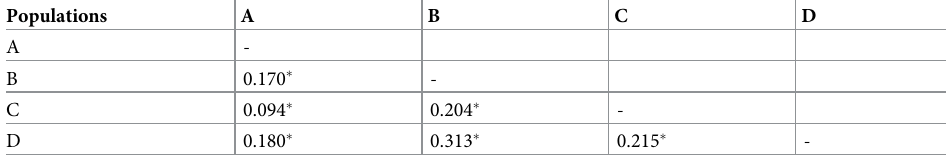
the pairwise F is between 0 and 0.05, it implies a low level of genetic differentiation between ST the populations [48]. In this study, the population genetic structure of the pairwise F values ST showed a significant genetic differentiation between the most populations, based on the analy- sis of the 16S rRNA and COI genes. Moreover, the phylogenetic analysis and haplotype net- work construction showed the lack of clear population genetic structures. This suggests that the gene flow within the C . siamensis population in Thailand might bring about genetic homo- geneity [49]. In this study, almost all of the pairwise F values, based on the 16S rRNA and ST COI sequences between the populations, were over 0.15. In contrast, the pairwise F based ST values on the 16S rRNA sequences, showed different results in some populations compared to the COI sequences. This suggested that the 16S rRNA gene had a relatively slow of evolution rate, and a low variability, compared to the COI gene [44, 50]. This agreed with the study of Feng et al. (2011), who found more variable nucleotide sites in the COI gene than in the 16S rRNA in the mollusk of the family Pectinidae. Genetic differentiation of C . siamensis popula- tion may be affected by the ecological environment, climate barriers, and geographic barrier factors [2, 29]. This was supported by previous studies that showed that the ecological environ- ment factor on population differentiation, has been reported in other land snails, such as Camaena cicatricose [29] and Cyclophorus fulguratus [42, 51]. In addition, the migration and expansion repeated of population from different areas lead to continuously mix the popula- tions of land snails. It is likely to affect accumulation of high genetic diversity within the popu- lation of the species. This was reported in pulmonate snail, Euhadra quaesita [52]. It may be possible reason leading to the genetic different in population of C . siamensis . The genetic homogeneity of C . siamensis in Thailand based on 16S rRNA and COI genes was found among some populations. The results suggested that extensive gene-flow was a pos- sibility. In support of this, considerable levels of gene-flow have been reported among C . sia- mensis populations in Thailand. Populations of C . siamensis in the areas with a low level of genetic differentiation, exhibit higher levels of gene flow than the populations with a high genetic differentiation [53]. Although this particular land snail has a low dispersal ability, the water, wind, anthropochory, and other factors, can lead to a wider distribution, especially for Table 5. Population pairwise F ST between 4 populations of Cryptozona siamensis in Thailand, based on the mito- chondrial cytochrome c oxidase subunit I gene sequences. Populations A B